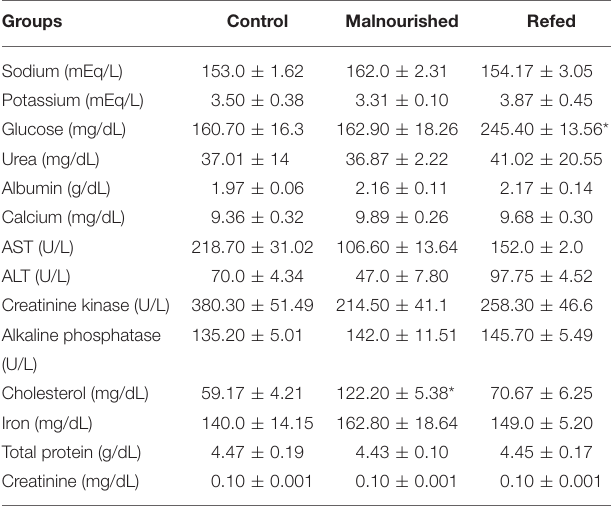
TABLE 5 | Biochemical parameters at the end of the experiment (on day 16 after diet